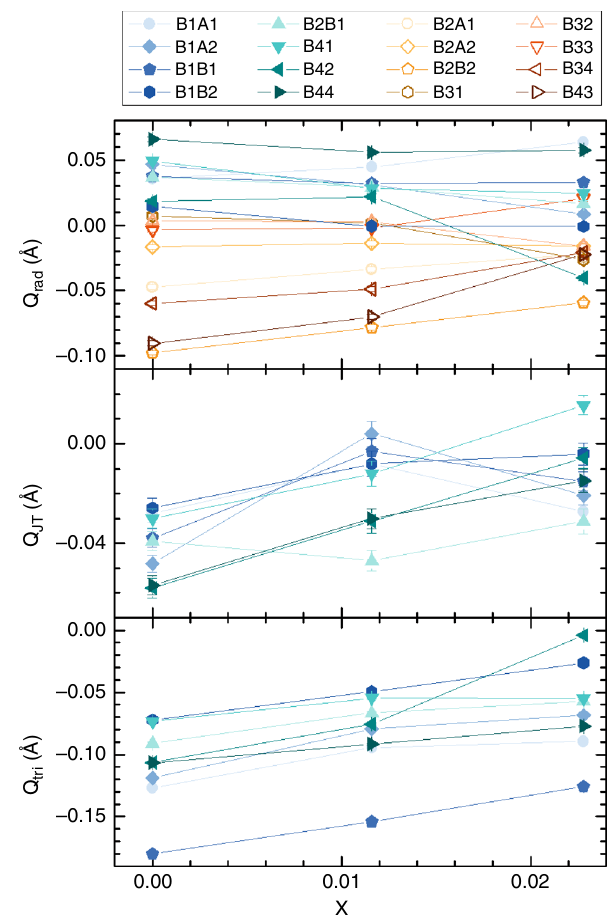
Fig. 2 Evolution of local distortion modes with hole doping in magnetite. Plots from top to bottom show the Q rad radial distortion parameters for all 16 octahedral B sites, the Q JT tetragonal Jahn – Teller distortions for the eight Fe 2 + sites, and the Q tri trimeron shortening of Fe – Fe distances around the Fe 2 + sites. B-site labels shown at the top are the same as used in previous studies 8,9 , with the eight Fe 2 + sites in blue – green symbols to the left, and the eight Fe 3 + sites with yellow – brown symbols to the right. Error bars are calculated from estimated standard deviations from the re fi